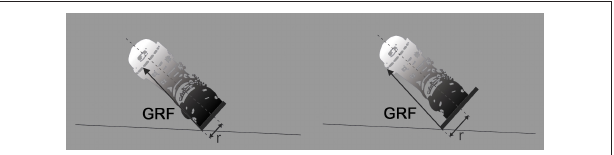
FIGURE 1 | In a ski turn on hard frozen snow, the contact point of the ground reaction force (GRF) of the outside ski is shifted more medially with a wide ski (right: dw) than with a narrow one (left: dn).